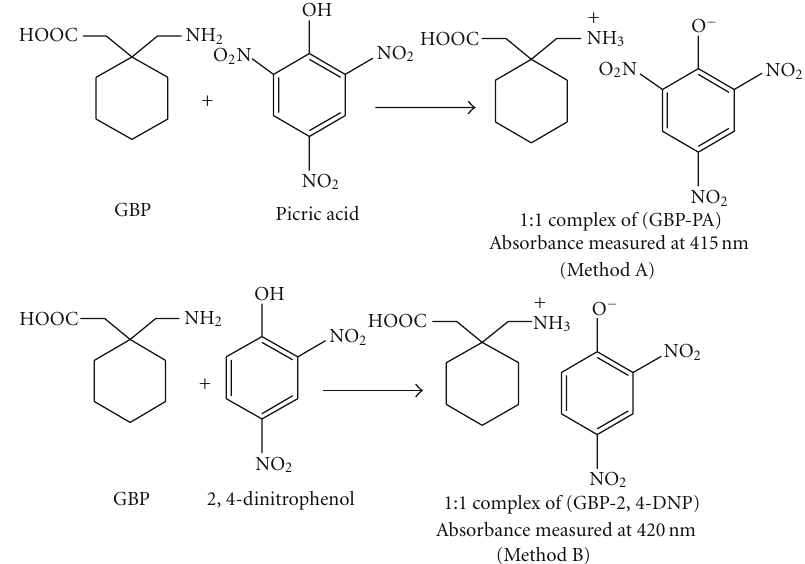
Figure 2: The probable reaction mechanism for the formation of GBP-PA and GBP-2,4-DNP ion-pair complexes.